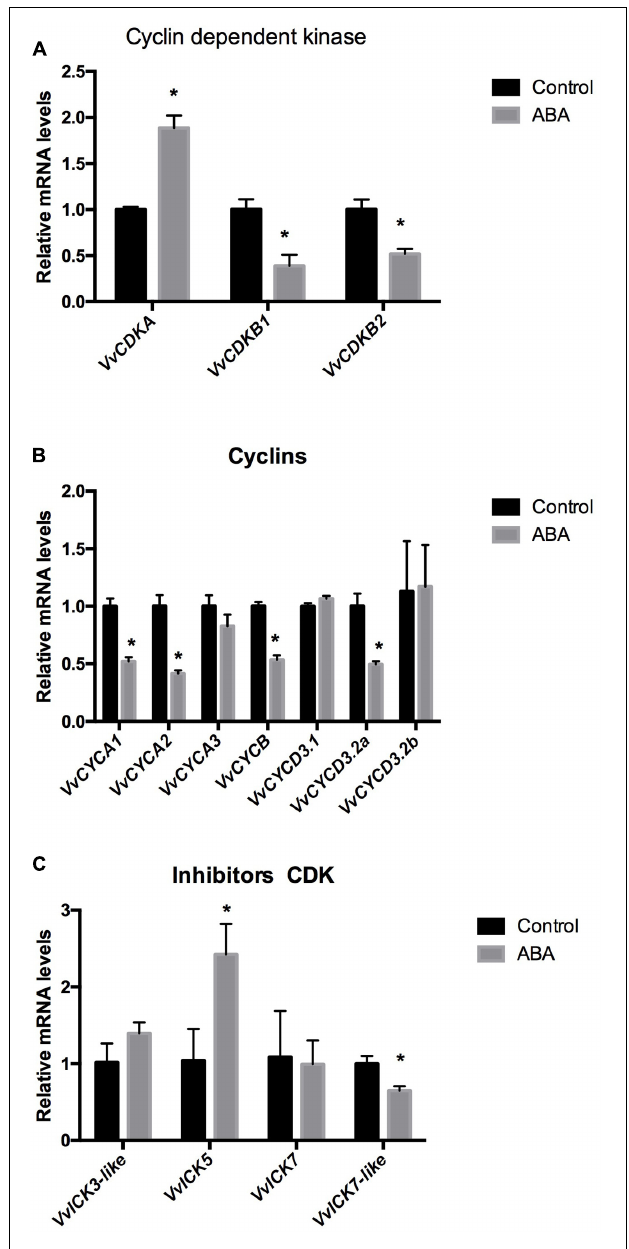
FIGURE 3 | Effect of ABA on the expression of (A) cyclin-dependent kinases ( VvCDKs ), (B) cyclins ( VvCYCs ) and (C) inhibitors of CDKs ( VvICKs ) on Thompson seedless somatic embryos.Gene expression analysis was performed by RT-qPCR and normalized against VvACTIN . Values are the average of three biological replicates with three technical repetitions ± SD; (asterisk) Student’s t -test ( α =